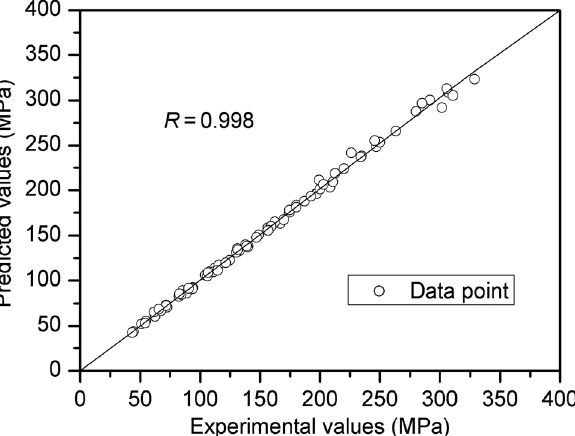
Figure 11: Correlation between experimental flow stress values of Nimonic 80A and predicted ones from the developed constitutive